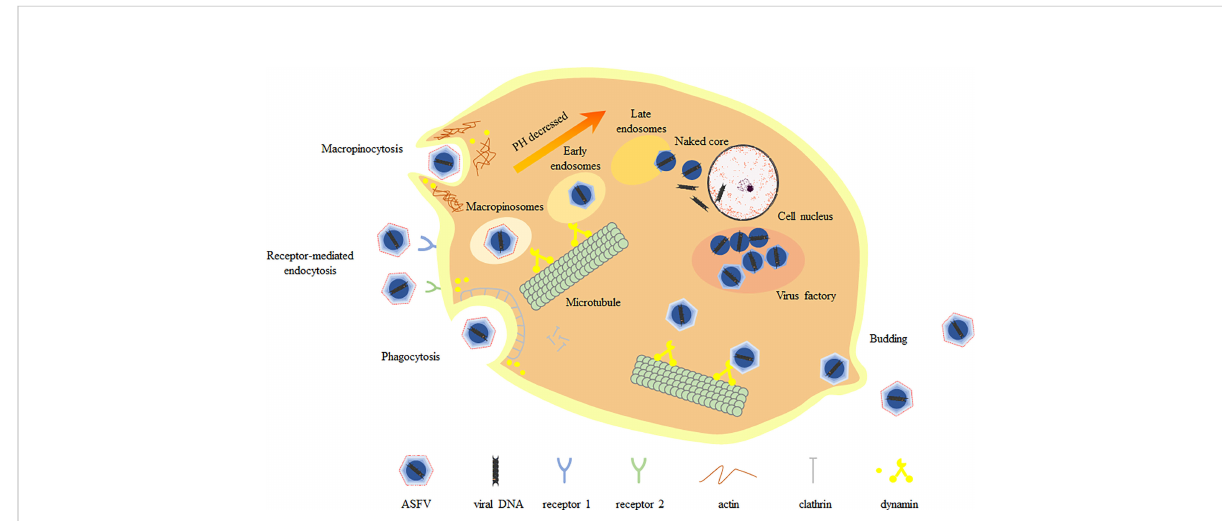
FIGURE 1 Replication cycle of ASFV. ASFV enters host cells mainly through macropinocytosis and endocytosis, during which the capsid is removed. Endosomes migrate, mature and acidify in the cell, gradually forming multiple vesicles (MVB), late endosomes (LE) and endosomal lysosomes. The fusion of the viral inner membrane with the late endosomal membrane releases the viral core into the cytoplasm. The virus core is routed to the virus factory through microtubule system. Mature virions arrive at the cell surface by microtubule-mediated transporting and fi nally release from the cell by budding on the plasma